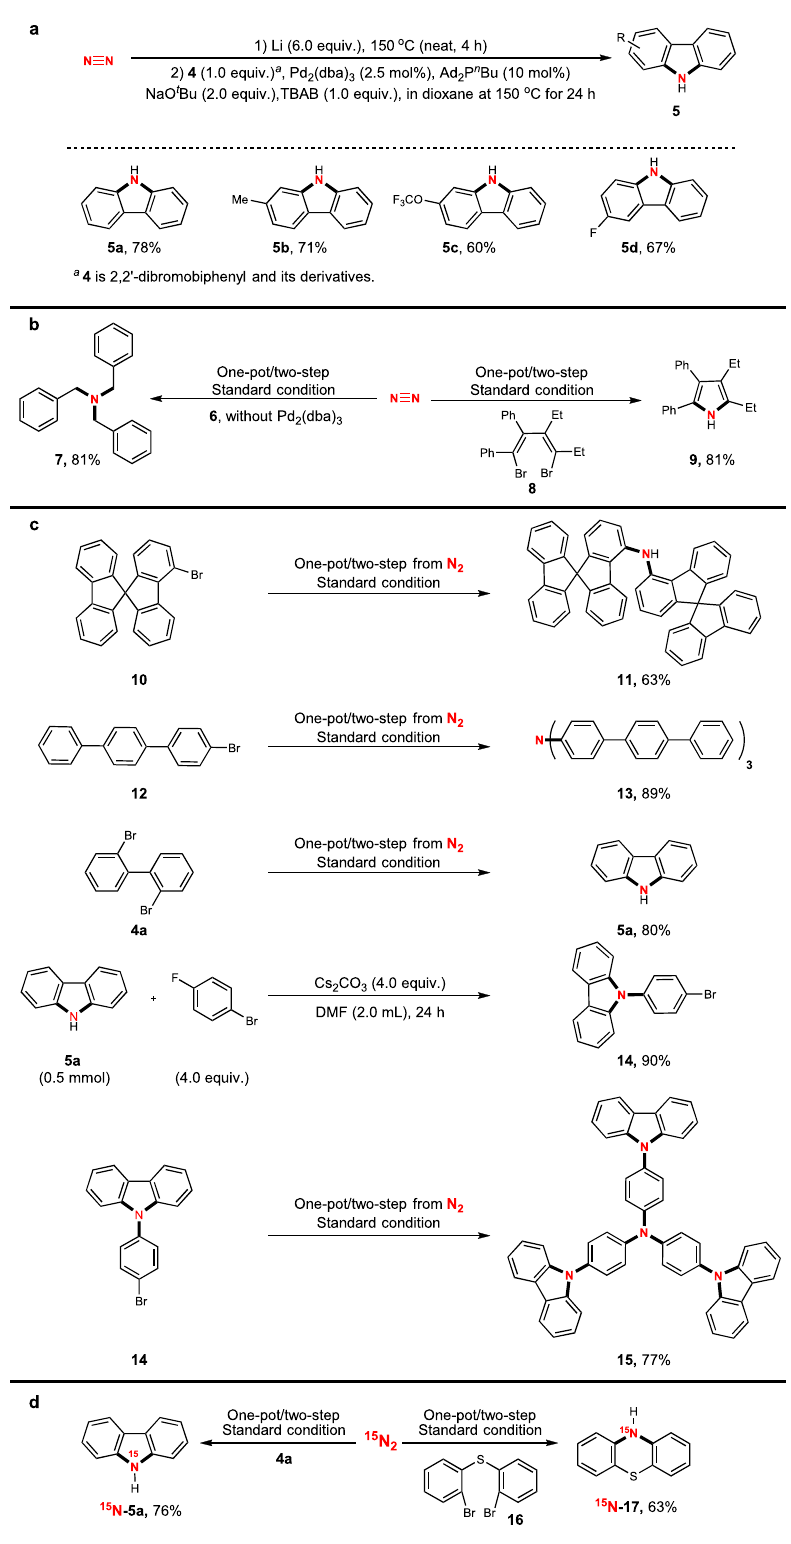
NATURE COMMUNICATIONS| (2021) 12:248 |https://doi.org/10.1038/s41467-020-20270-5|www.nature.com/naturecommunications